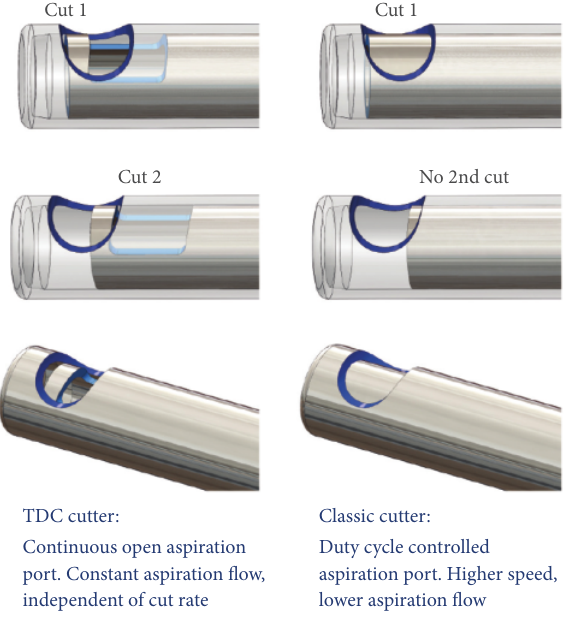
Figure 1: TDC vitrectome design and classic single-cut